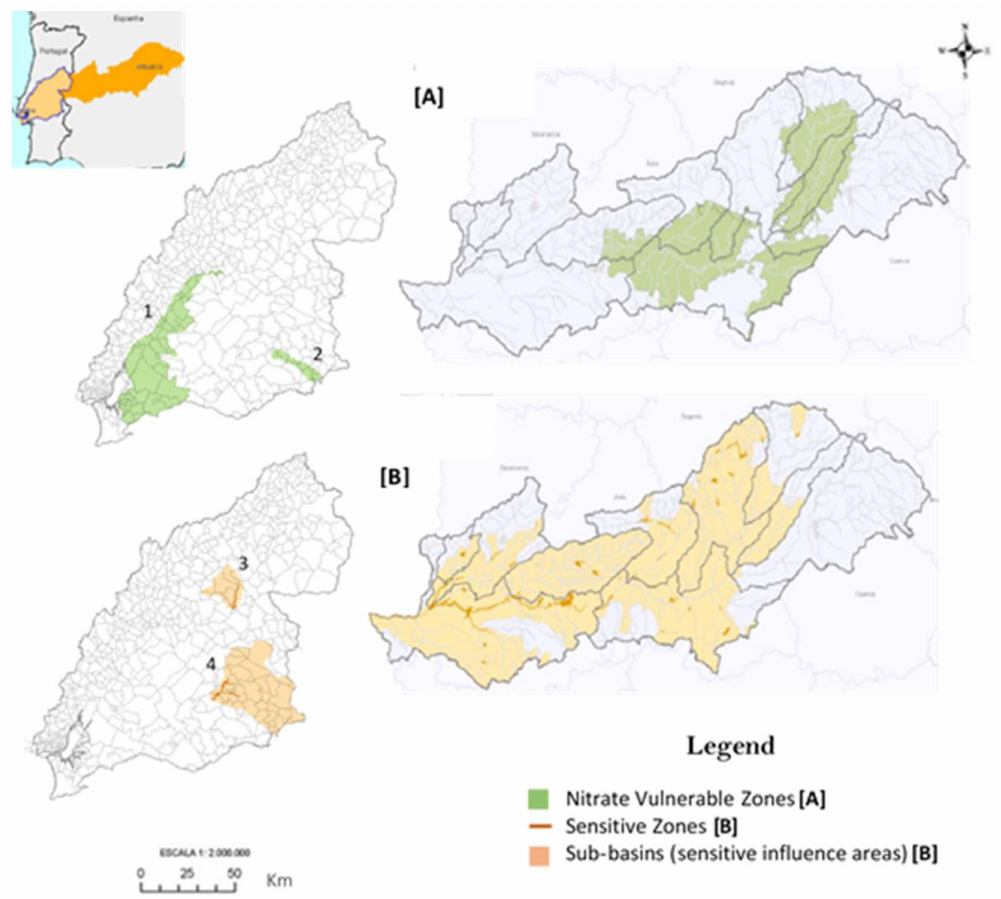
Figure 6. Nitrogen Vulnerable [ A ] and Sensitive [ B ] Zones in the Portuguese and Spanish sides of the Tagus River Basin (built with QGIS) [34,35,44,45]. Numbers correspond to Portuguese Tagus sections of Vulnerable (1-Tagus; 2-Estremoz-Cano) and Sensitive (3-Pracana reservoir; 4-Maranh ã o reservoir)